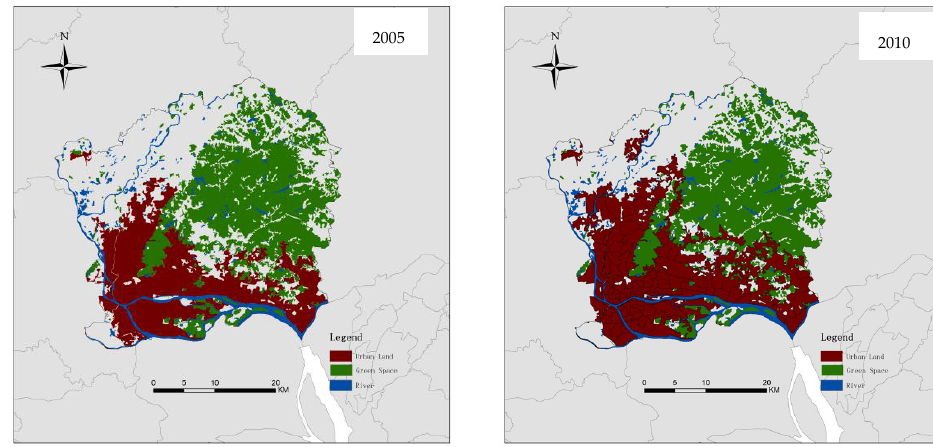
Figure 12. Urban expansion from 2005 to 2010. (Source: drawn by the authors).